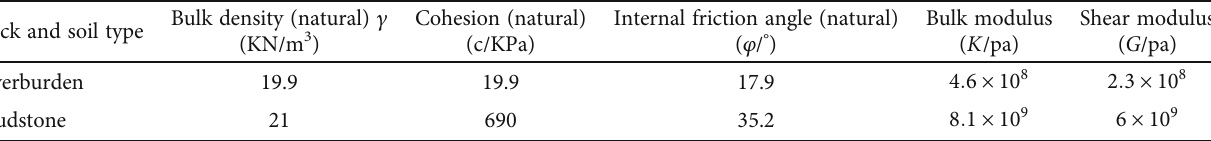
Table 2: Model parameter value table.